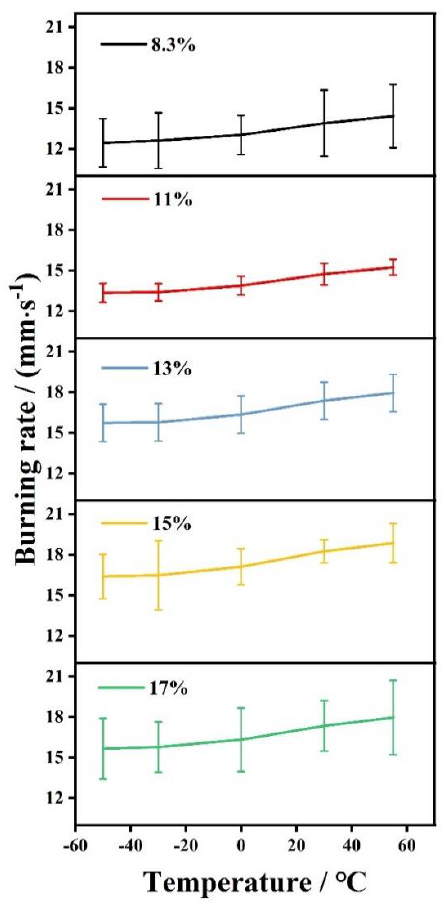
Figure 6. The influence of temperature on the burning rate of B/NC/CuO